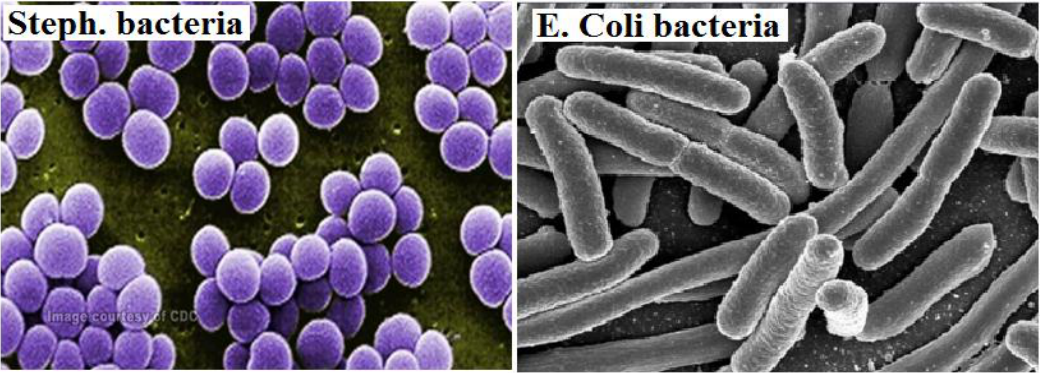
Fig. 1: Shape and color E.coli bacteria